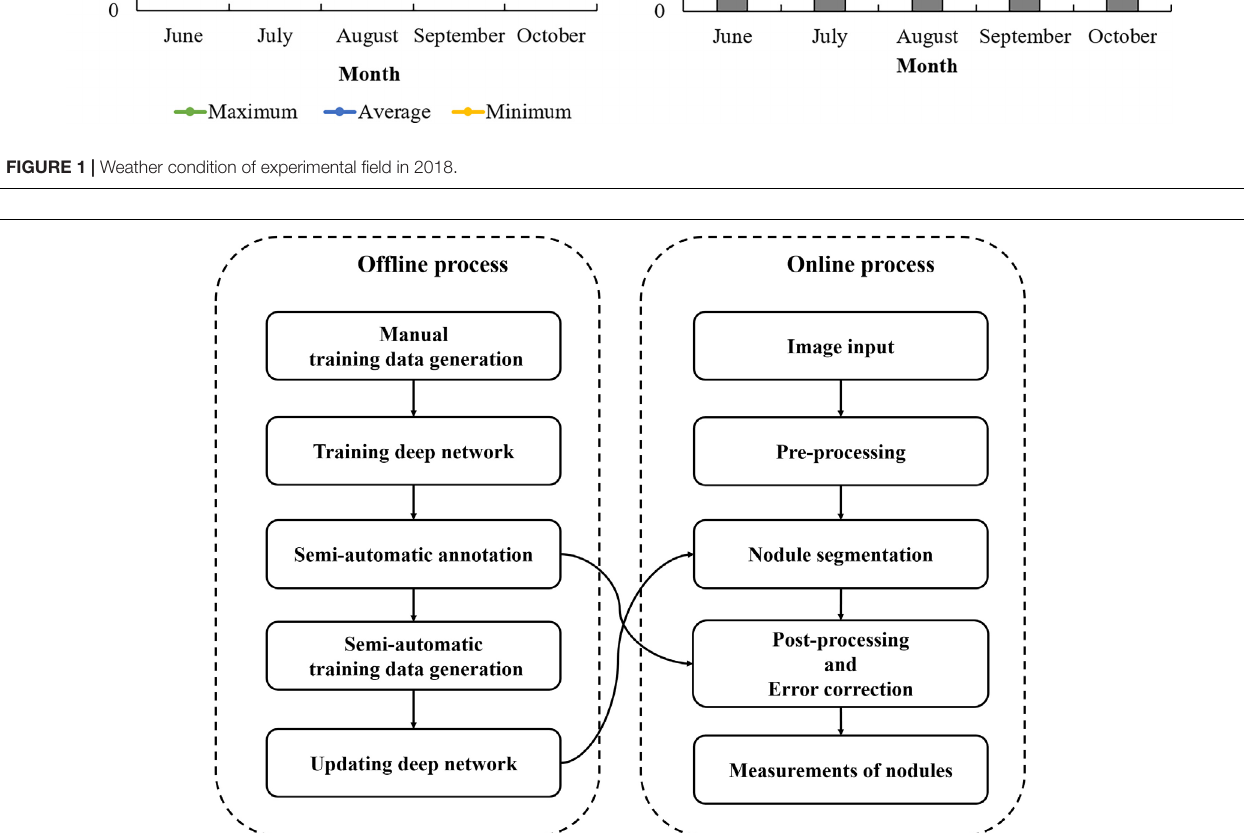
FIGURE 2 | Image analysis